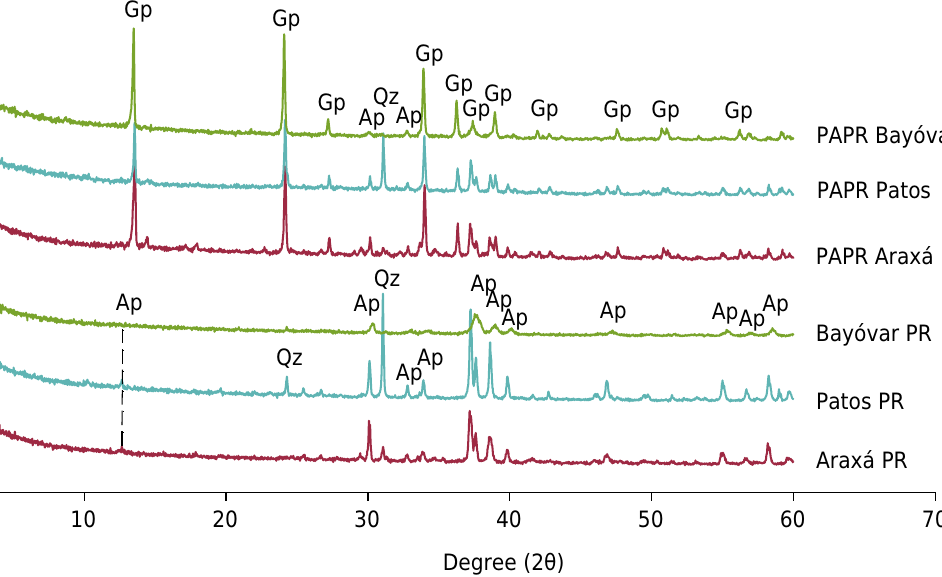
Figure 1. X-ray diffraction patterns from phosphate rocks (Araxá PR, Patos PR, and Bayóvar PR) and their respective partially acidulated forms (PAPRs), using a wastewater diluted in water to 18, 20, and 25 % (v/v), respectively. Ap = apatite; Gp = gypsum; Qz = quartz. Data were collected using Co- Ka1 radiation (1.789